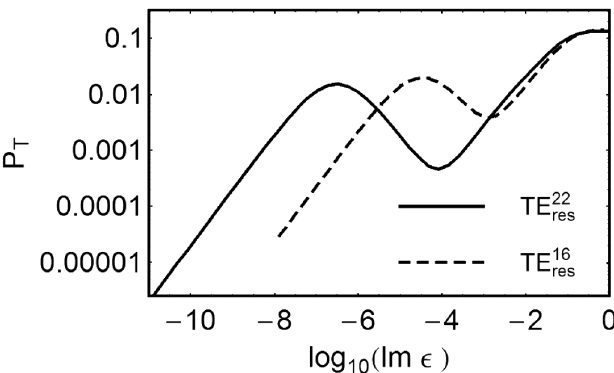
FIG. 11. Average power entering the dielectric spheres at two WGM resonances as the function of Im (cid:1)